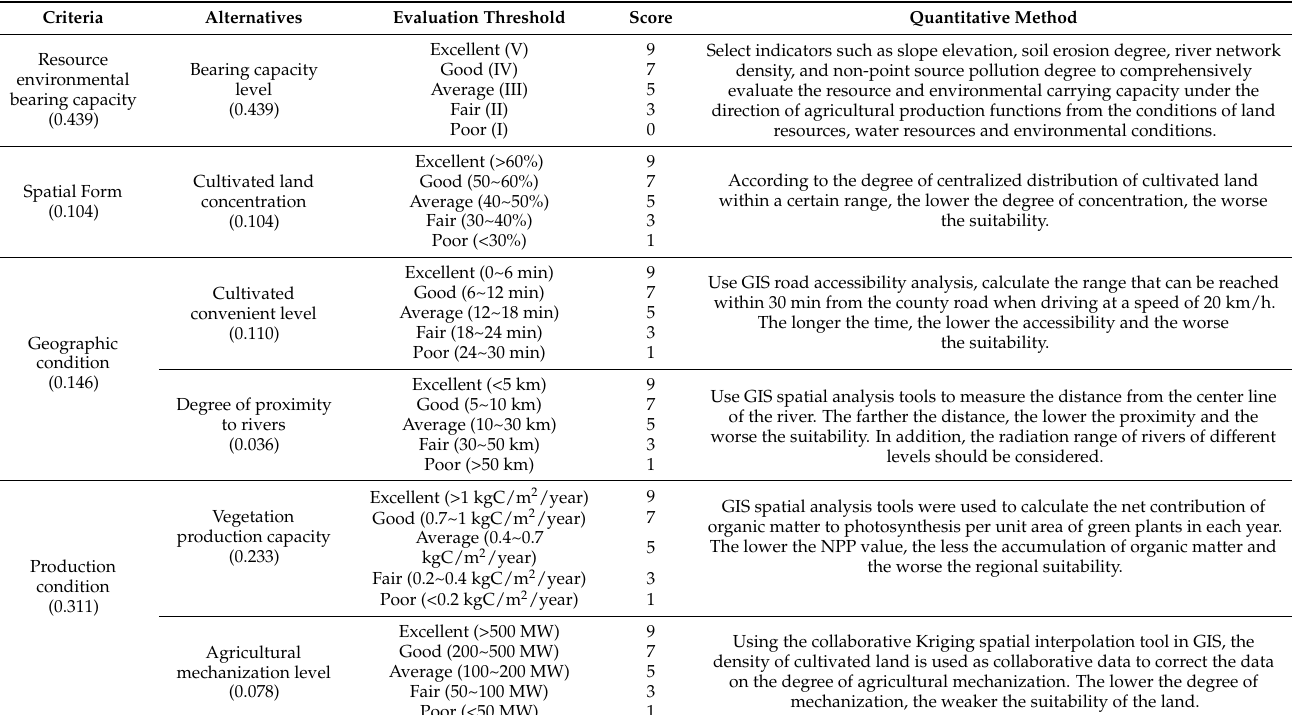
Table 1. Indicator weights and classification thresholds of agricultural production space